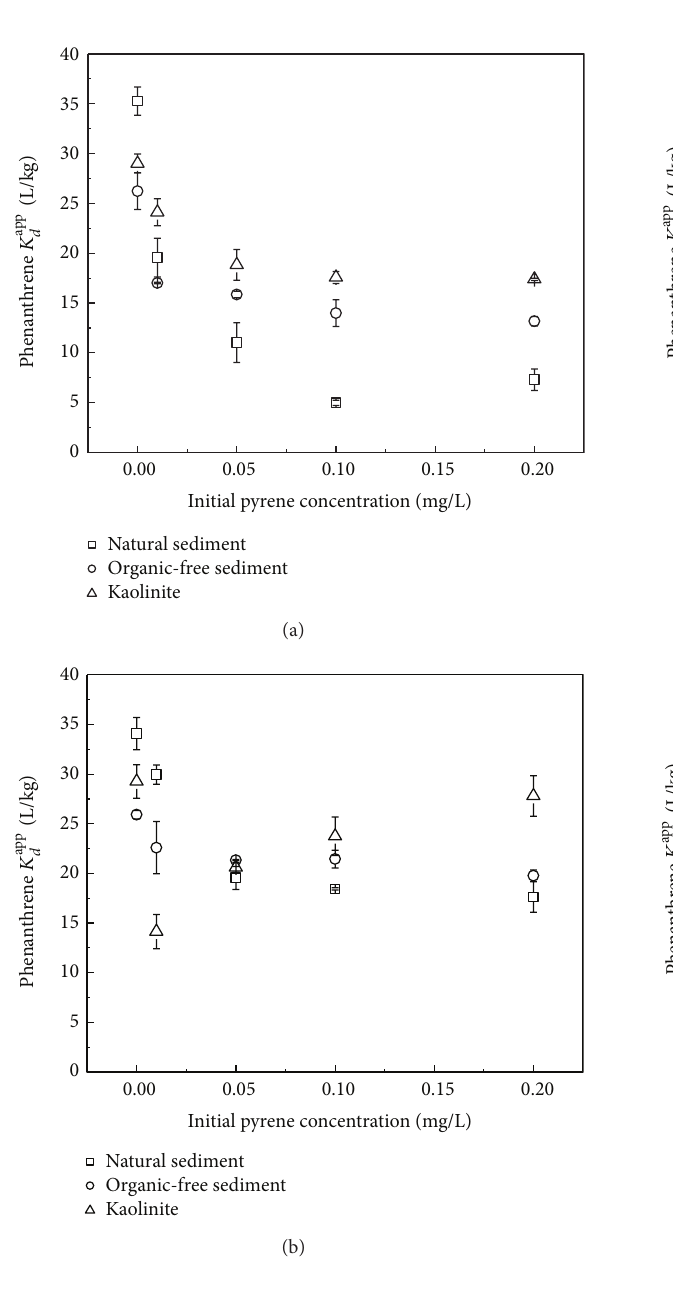
Figure 3: Effect of pyrene on 𝐾 𝑑 app of phenanthrene. (a) Group 1; (b) Group 2.